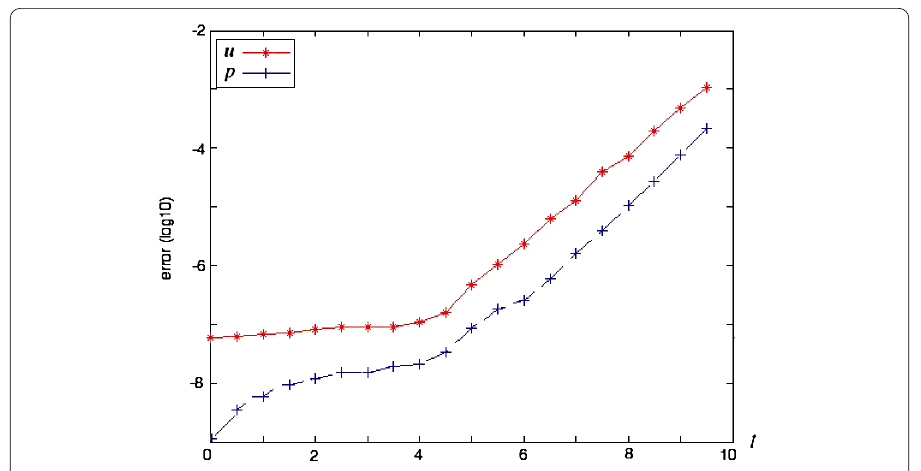
Figure 7 The relative error trending charts of the SMFE solutions of the fluid velocity u and the pressure p on 0 ≤ t ≤ 10.